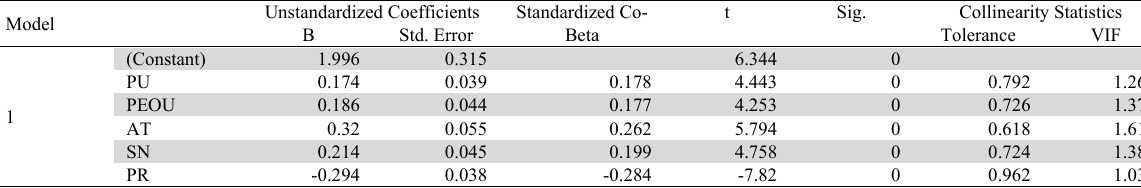
Result of multiple regression of factors impact online shopping intention